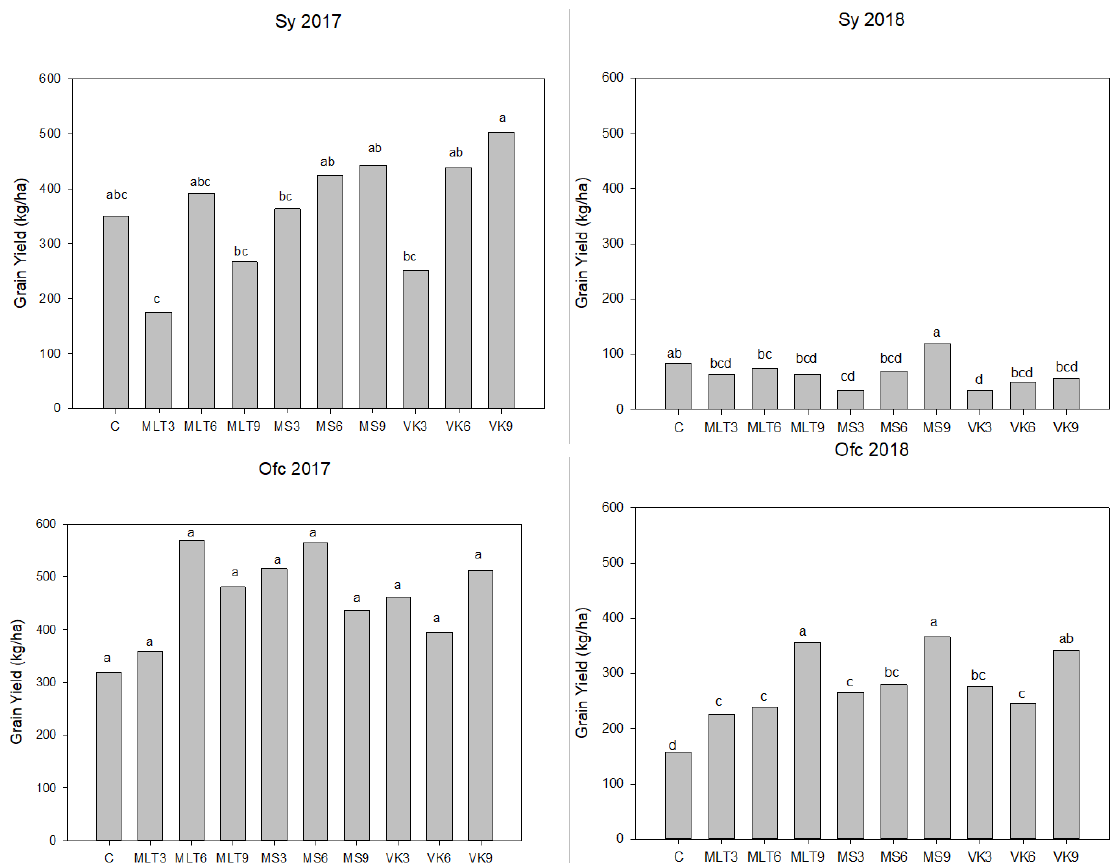
Figure 2. Grain yield at Syferkuil and Ofcolaco in the 2017 and 2018 seasons. MLT is Moringa Oleifera leaves and twigs applied at rates of 3 tons/ha (MLT3), 6 tons/ha (MLT6) and 9 tons/ha (MLT9); MS is M. Oleifera stems applied at rates of 3 tons/ha (MS3), 6 tons/ha (MS6) and 9 tons/ha (MS9); VK is Vachelia Karoo leaves and twigs applied at rates of 3 tons/ha (VK3), 6 tons/ha (VK6) and 9 tons/ha (VK9). Different letters show significant differences.